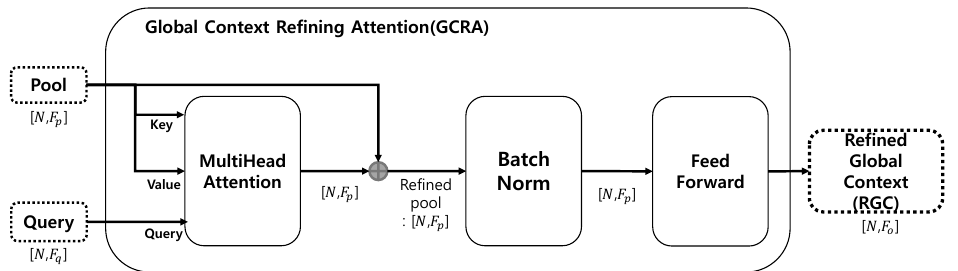
Figure 4. Illustration of Global Context Refining Attention (GCRA). F p is the pool input channel, F q is the query input channel, and F o is the output